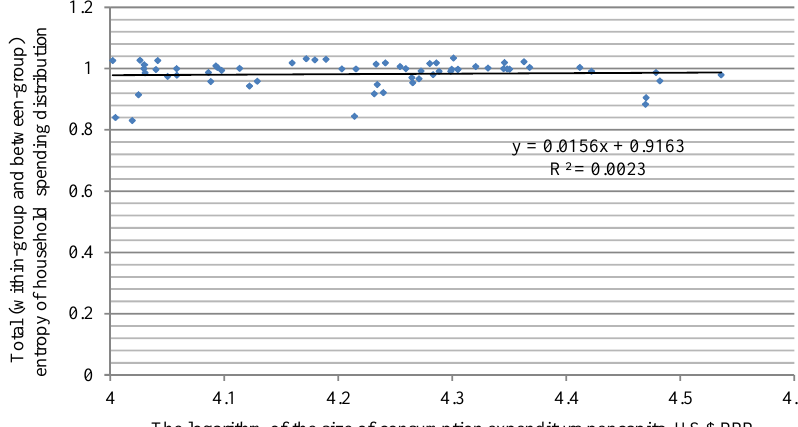
Figure 5. Linear regression for link "the absolute size of consumer spending — a measure of diversity of consumer spending (total entropy)" for 63 countries with highest household spending